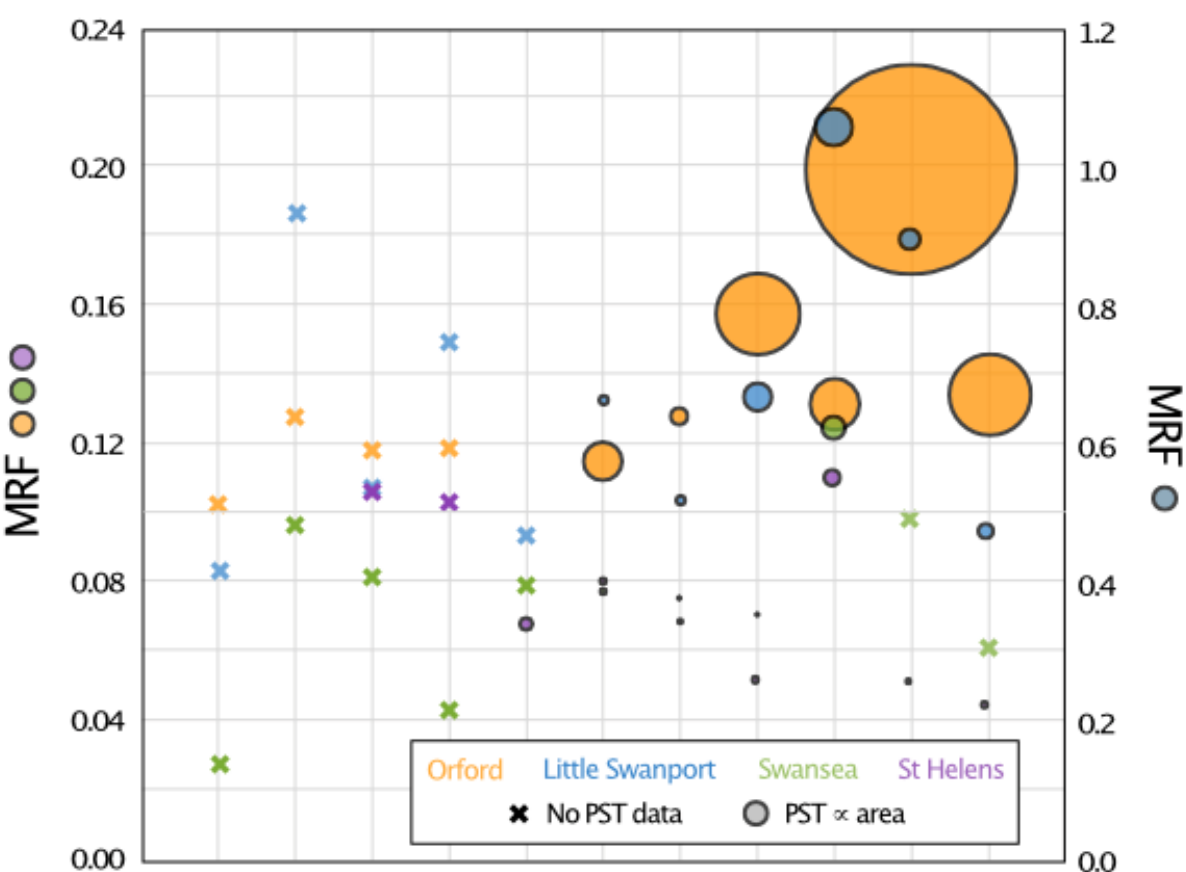
Figure 7. Timeseries of the meteorological risk factor (MRF), which broadly represents the ratio of the meteorological energy inputs enhancing stratification to the energy inputs eroding stratification. Specifically, MFR is defined as the maximum of average daily rainfall and weighted daily minimum air temperature (high values enhance ocean stratification) divided by the average cubed windspeed (high values erode ocean stratification), calculated monthly for the bloom season (June to October) and then annually averaged for 2008–2018 for four locations along the Tasmanian east coast. Locations are colour-coded and bubble area is proportional to observed paralytic shellfish toxin levels from 2012–2018. MFR is also plotted prior to 2012 and for years after 2012 when no toxin data was available (crosses) to demonstrate the longer-term upward trend in MFR and associated toxic bloom risk. Adapted from [59].